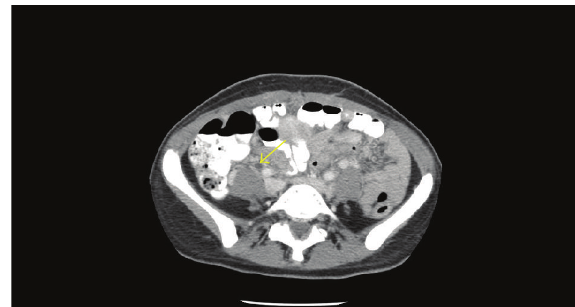
Figure 1: A CT scan of the abdomen showing hyperdense area adjacent to the pancreas and consistent with hemorrhagic